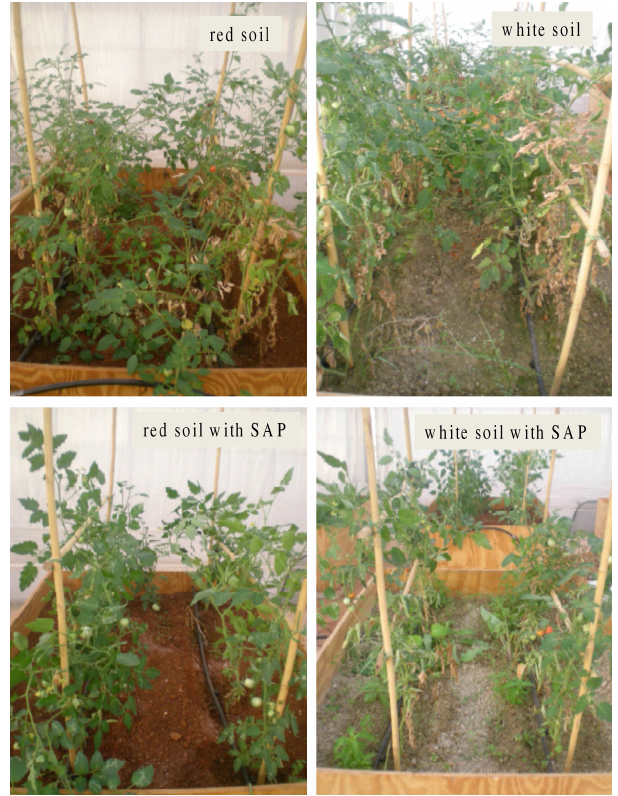
Figure 8. Comparison of the growth of tomato plants in the different types of soil, with and without the addition of